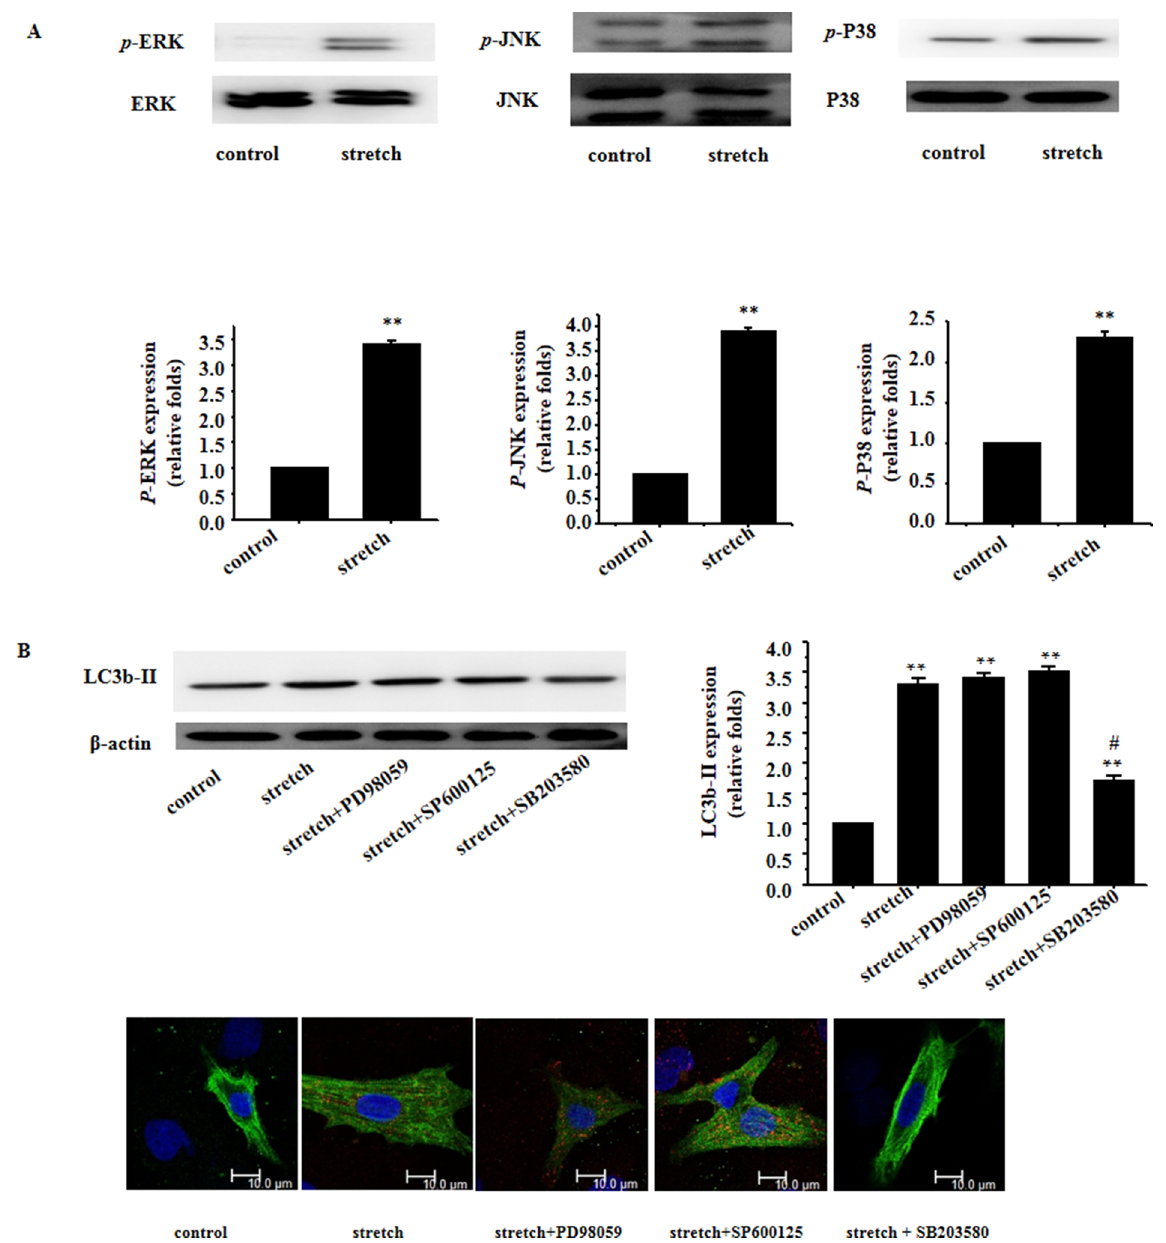
Figure 2. Involvement of p38MAP kinase in mechanical stretch-induced cardiomyocyte autophagy. A : Phosphorylation of ERKs, JNK and p38MAP kinase was examined using Western blotting; Total protein levels of ERKs, JNK and p38MAP kinase were used as the loading control. Representative photograms were shown from 3 independent experiments; B : Western blot analyses and immunofluorescent staining for LC3b-II using the anti LC3b-II antibody (red); b -actin in whole cell lysate was used as the loading control. Representative photograms from 3 independent experiments are shown.